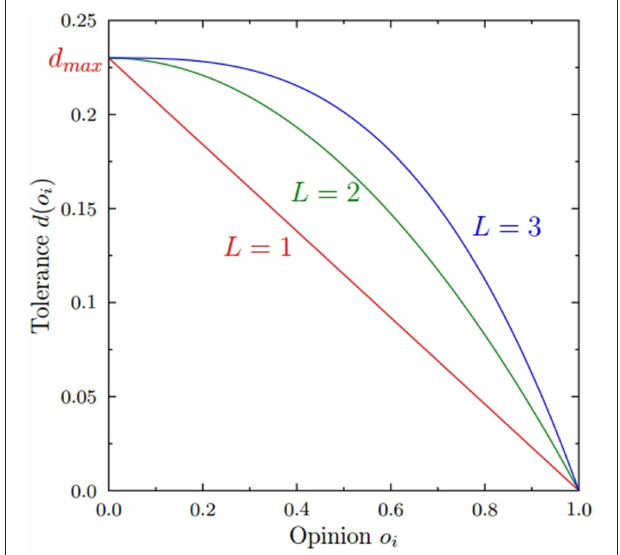
FIGURE 1 | Graphical example of the postulated form of the dependence of the tolerance d i on the current opinion o i , for L = 1 , 2 , 3 and d max = 0 . 23 and d min = 0 . 0001